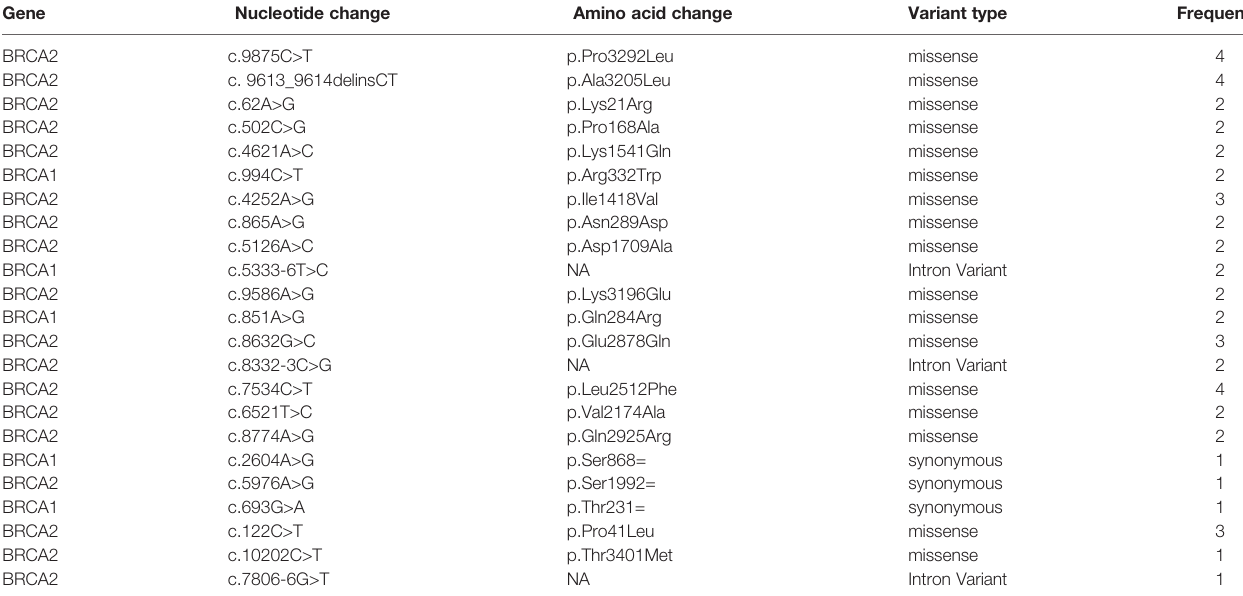
TABLE 3 | Variants of Uncertain Signi fi cance (VUS) Mutations in BRCA1 and BRCA2